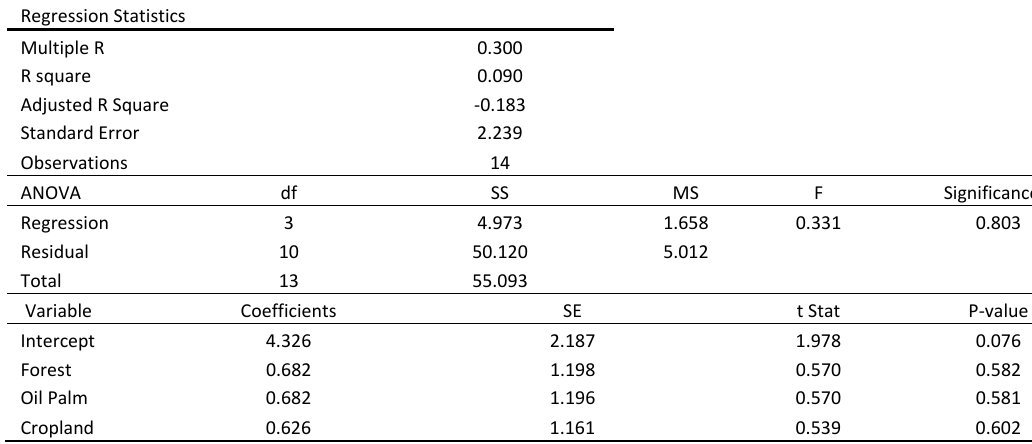
Table 5: Regression analysis of land cover changes and malaria incidence rate